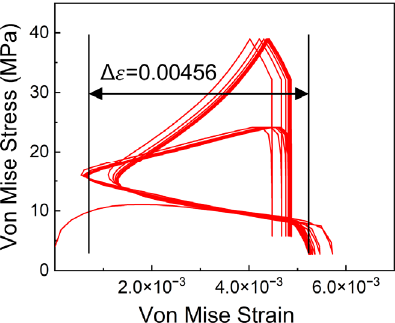
Figure 5. Stress ‐ strain relationship of the critical point during ten thermal cycles. Figure 5. Stress-strain relationship of the critical point during ten thermal